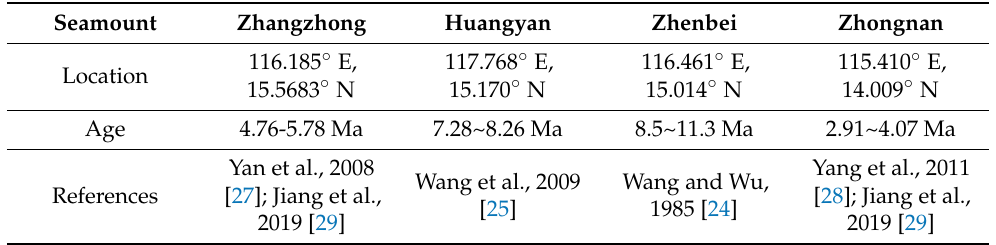
Table 1. The age of SCS seamounts.